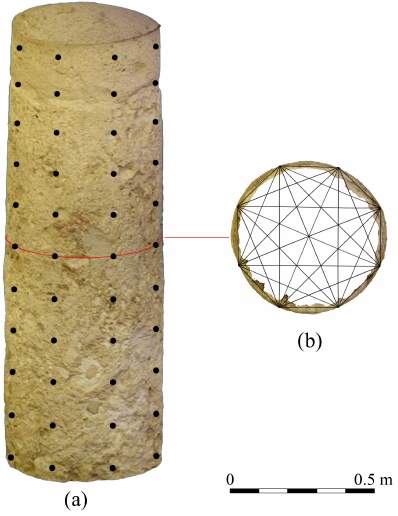
Figure 8. Ultrasonic tomography data acquisition: (a) transducer positions used for the tomographic reconstruction located on the 3D CRP-TLS model of the column; (b) 2D cross-section of the straight ray paths from the 3D acquisition scheme assuming a homogeneous